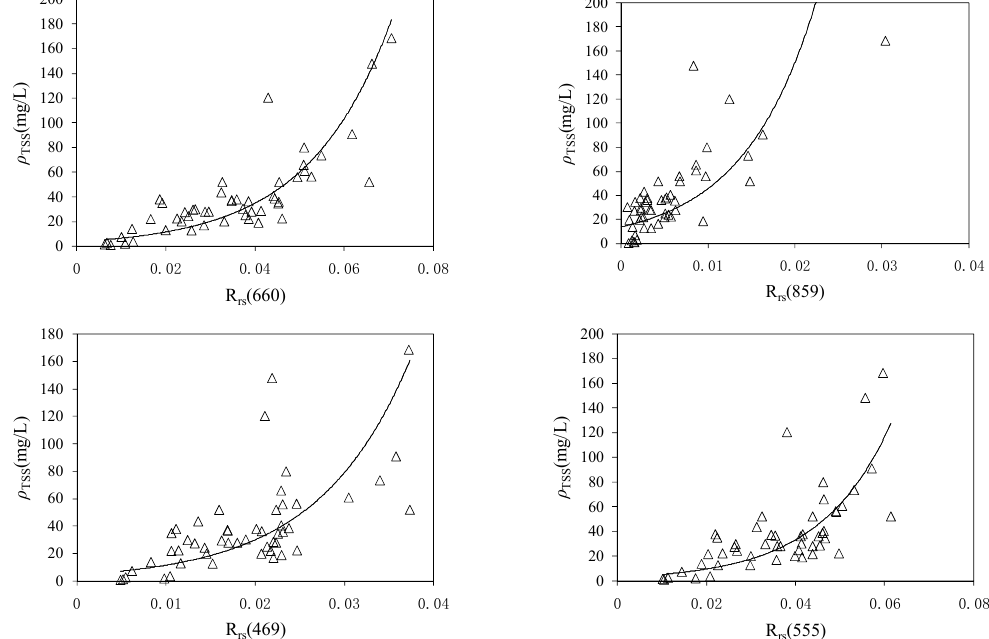
Figure 4. Comparison between total suspended sediment (TSS) and simulated Moderate-Resolution Imaging Spectroradiometer (MODIS)-derived single bands.